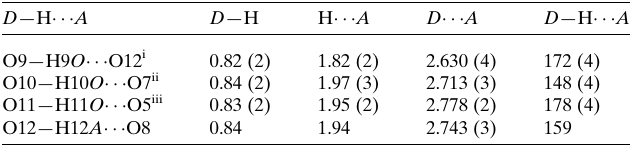
Table 3 Hydrogen-bond geometry (A˚ , (cid:5) ).